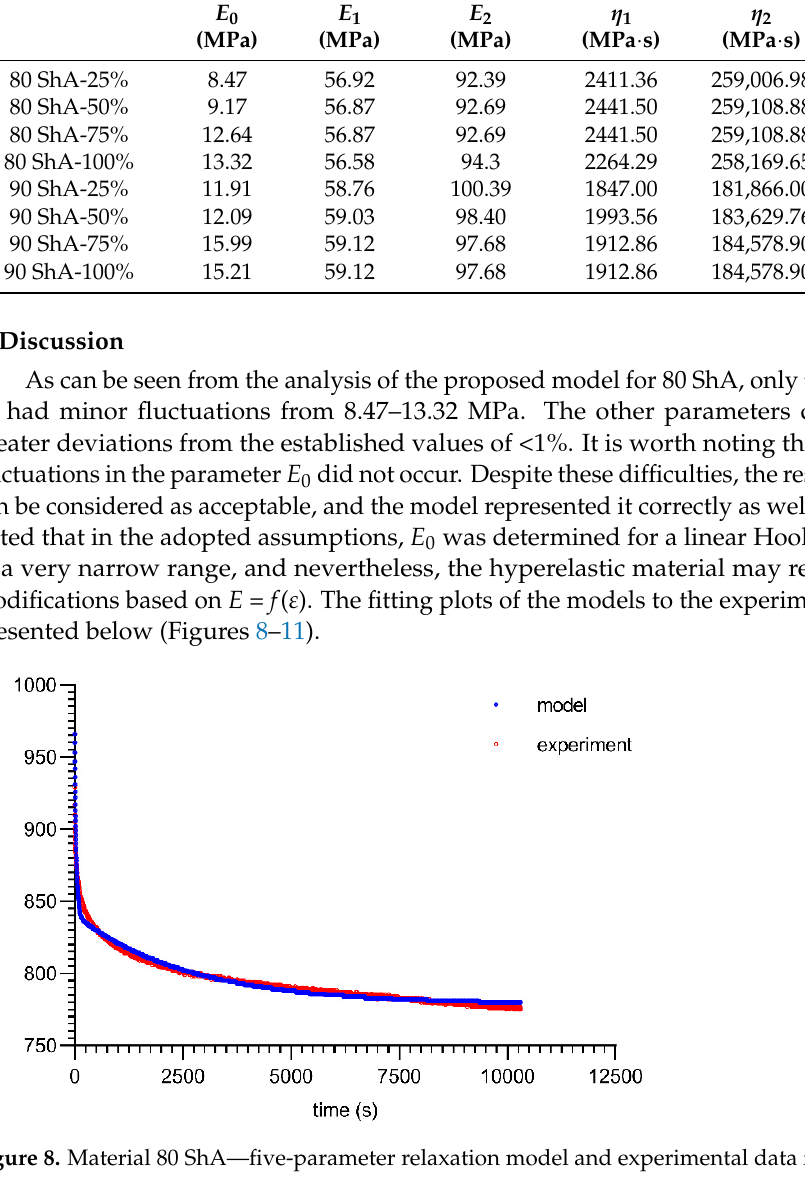
Figure 9. Material 80 ShA— fi ve-parameter relaxation model and experimental data for ε = 50% .